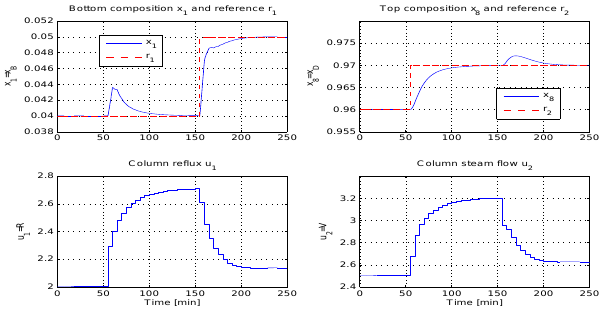
Figure 5: Simulation of the distillation column in Ex- ample 6.4 with LQ optimal